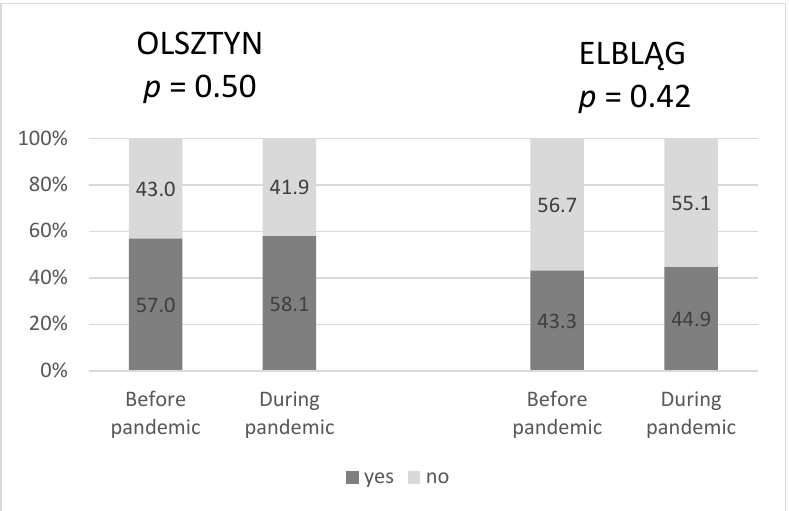
Figure 4. The percentage of patients treated with radiotherapy under DiLO before and during the